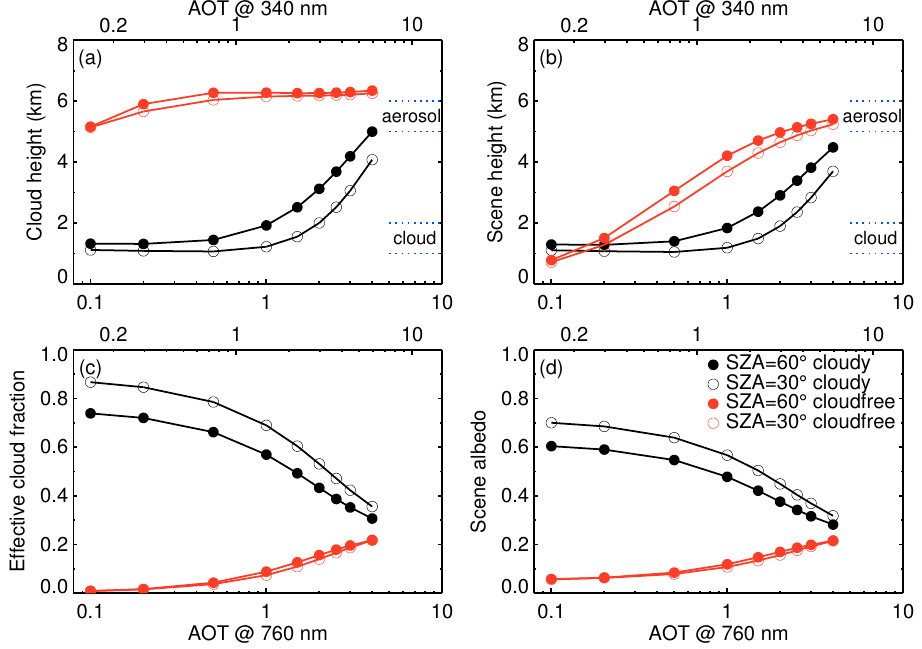
Fig. 6. Same as Fig. 5 but for the location of the dust aerosol layer between 5 and 6km.